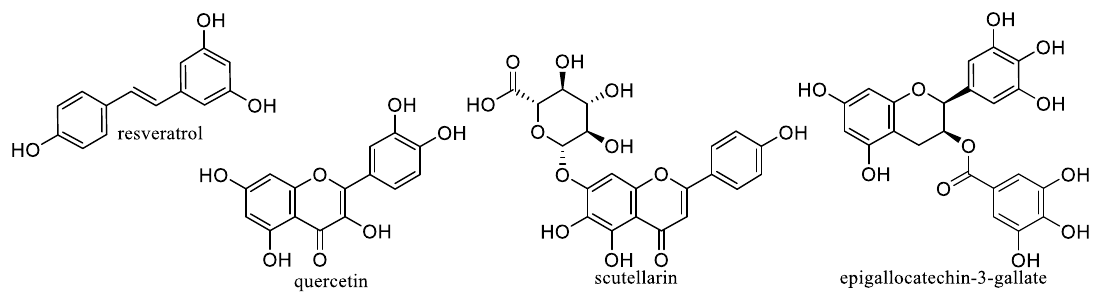
Figure 5. Structures of polyphenolic agents affecting immunity.